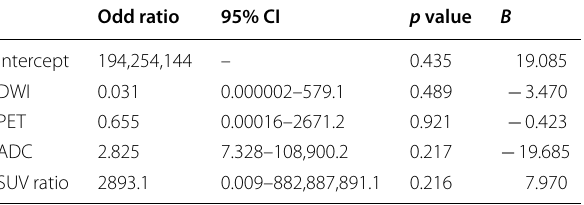
Table 5 Multinomial logistic regression model including all variables (using enter method) for predicting post‑TACE viable